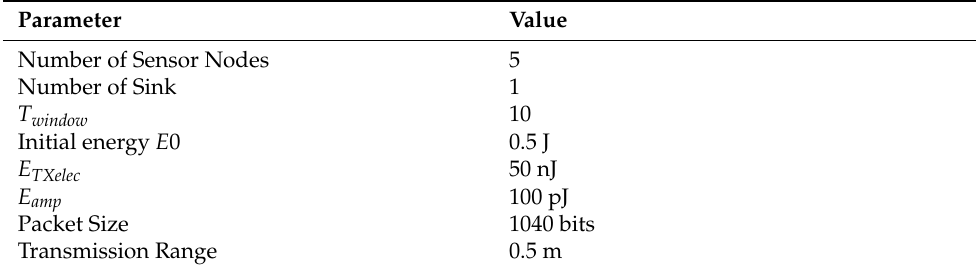
Table 3. Detailed